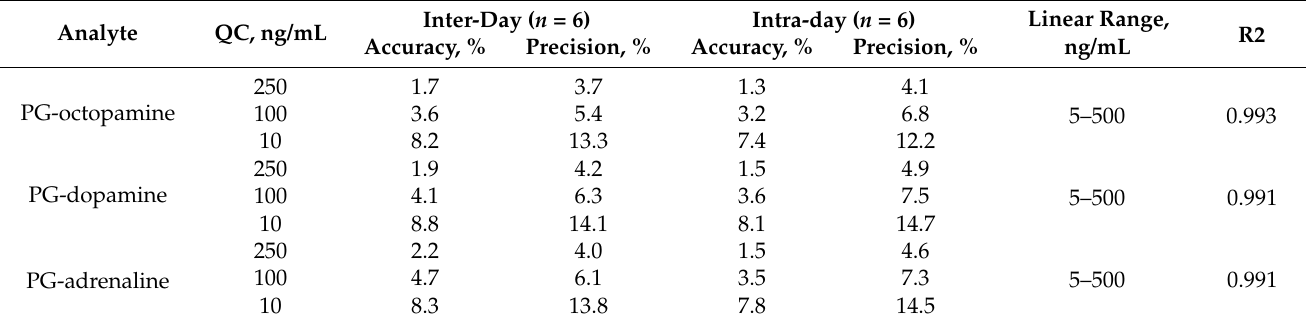
Table 3. Accuracy and precision results established on synthetic urine samples.